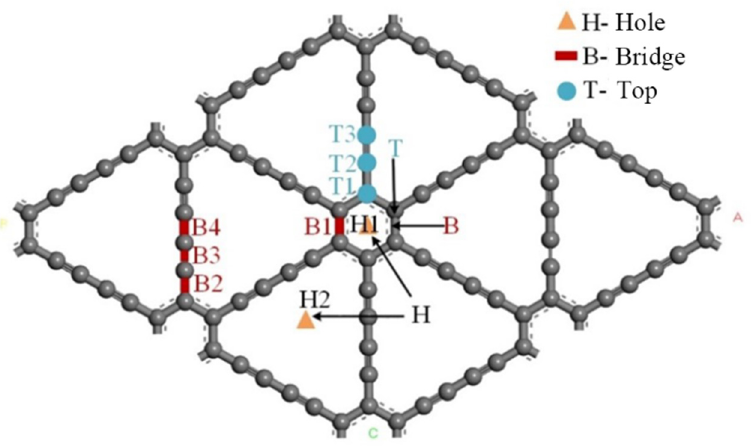
Figure 3. Schematic diagram of the nine highly symmetric adsorption points of intrinsic γ -GDY models.